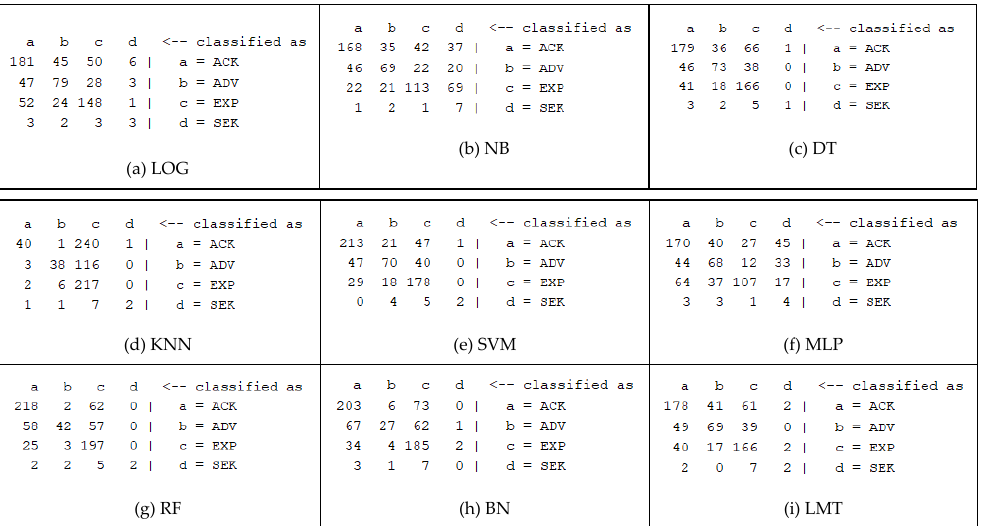
Figure 11. Confusion matrices.